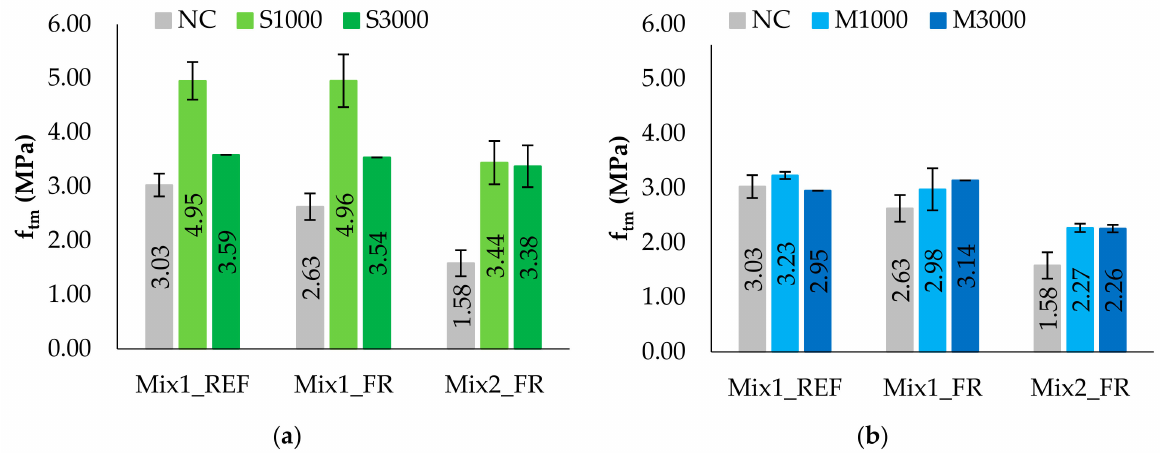
Figure 11. Flexural strength of NC and C specimens: ( a ) saline environment; ( b ) moisture environment.